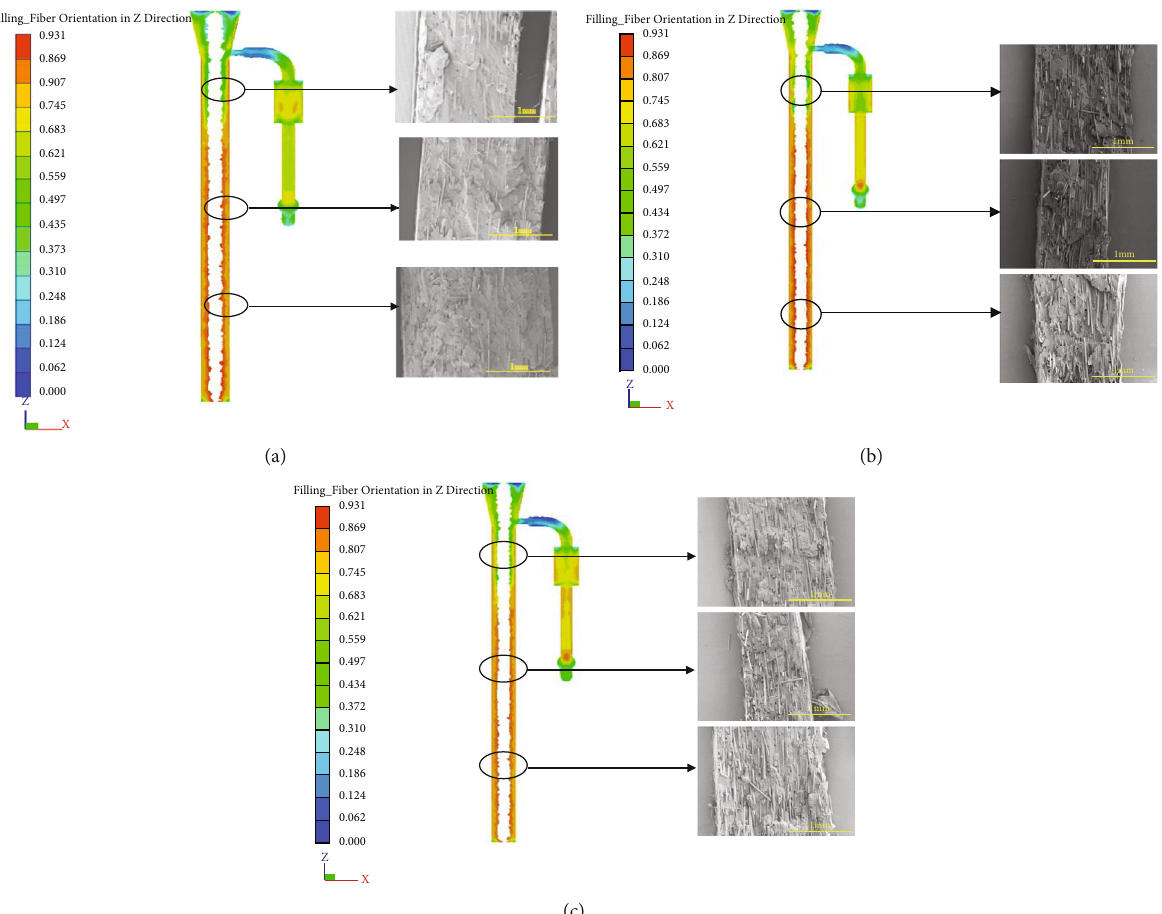
Figure 3: Fiber orientation distribution of di ff erent fi ber mass content along the fl ow direction.